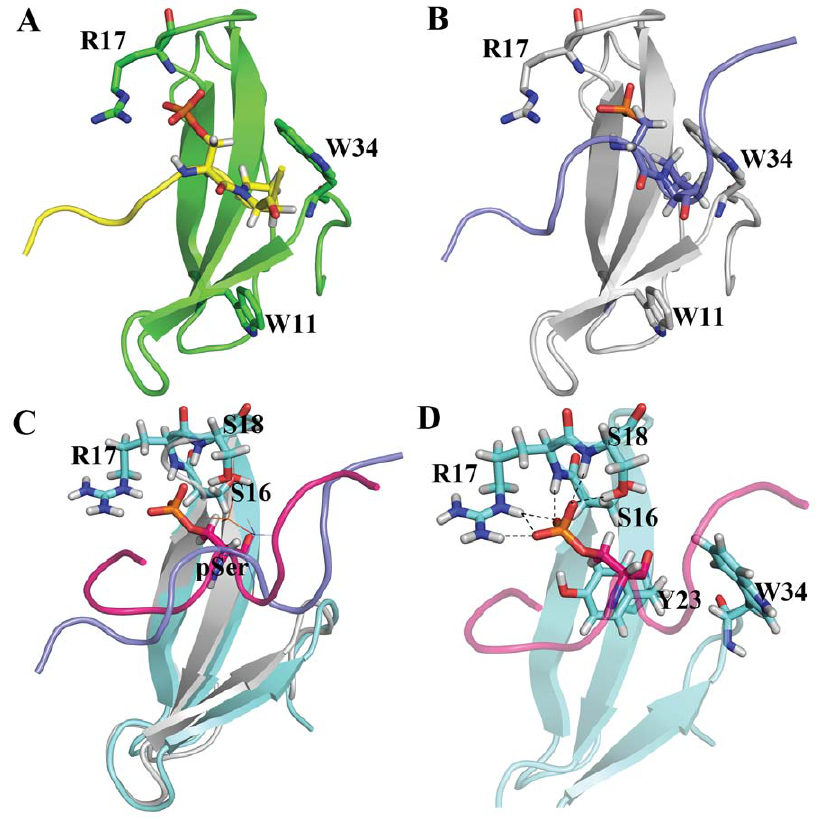
Figure 4. Model building and MD simulation result of Pin1-pS87 peptide. (A) Crystal structure of the Pin1 WW domain with C-terminal domain (CTD) of RNA polymerase II phosphopeptide. (B) Initial model of Pin1 WW domain with pS87 Bcl-2 phosphopeptide. Both the tryptophan residues and the phosphoserine-interacting arginine residue are highlighted as sticks, and labeled accordingly. Both phosphopeptides are highlighted with yellow (CTD peptide) and blue (pS87 Bcl-2 peptide), and the pSer-Pro motif in both the phosphopeptides is represented as sticks. (C) Initial and representative frames of MD simulation. Protein is represented with gray and cyan; pS87 peptide is highlighted with purple and pink for the initial and final frames, respectively. (D) Hydrogen bond interaction patterns of the phosphoserine with the WW domain residues. All three residues (2 serines and 1 arginine) are highlighted with sticks and labeled. Hydrogen bonds between the phosphoserine and the WW domain residues are represented with dashed lines.